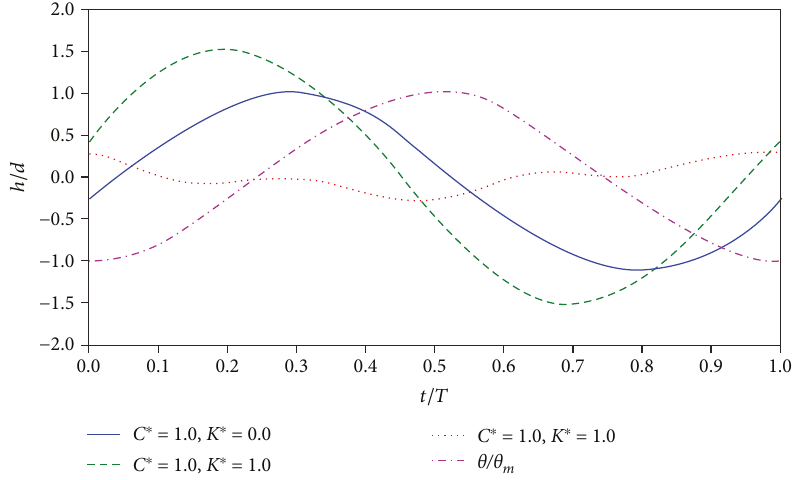
Figure 7: The time variation of h / d of the considered cases with K ∗ = 0 0 , 1.0, and 3.0, C ∗ = 1 0 .